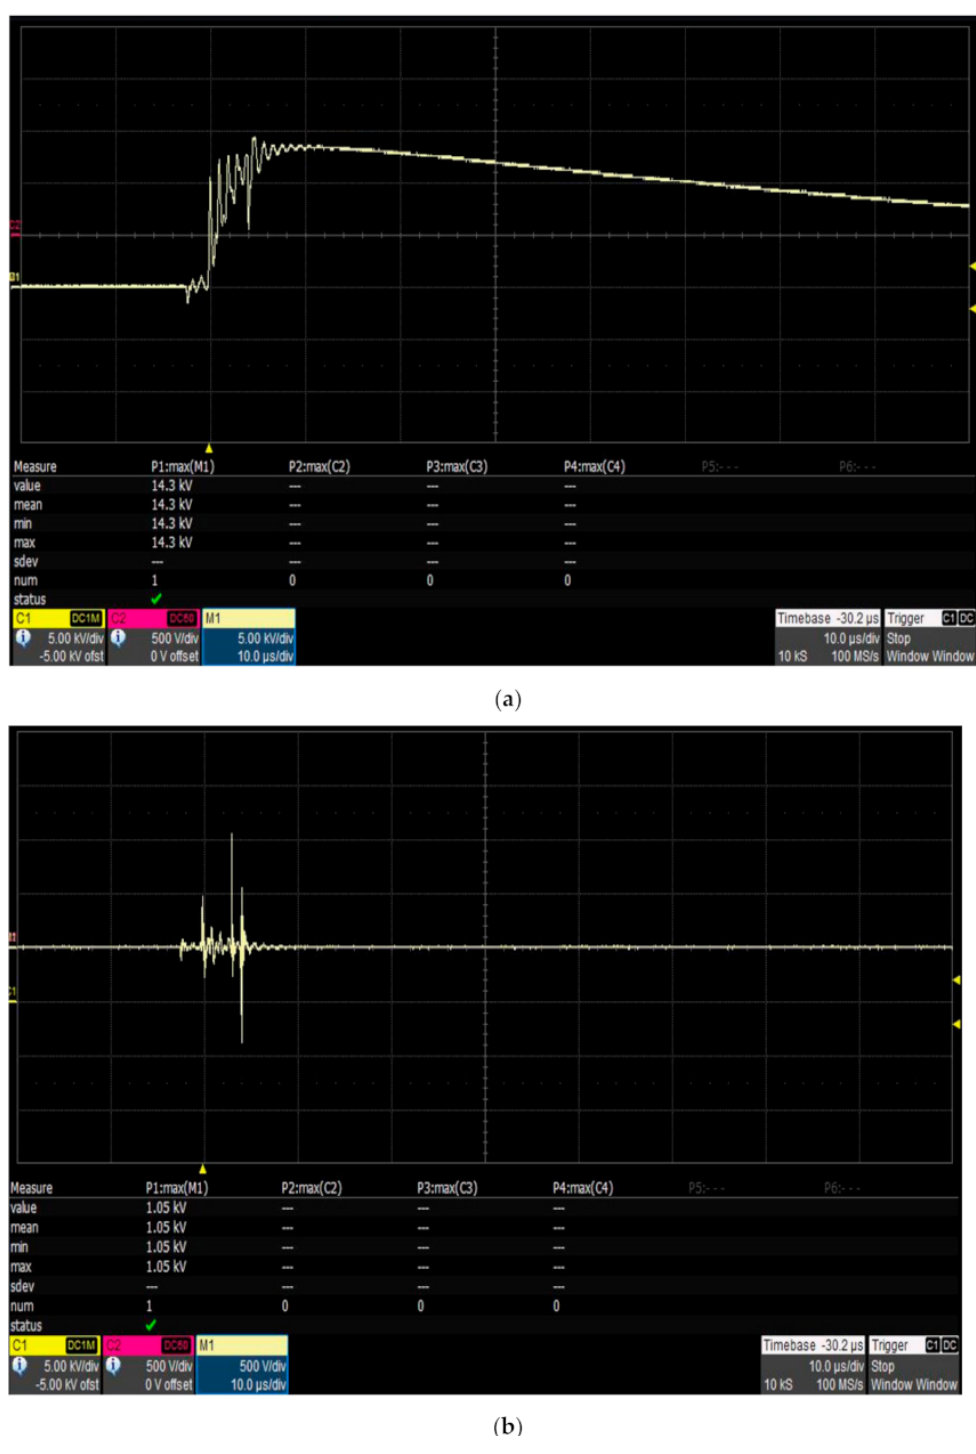
Figure 3. Measured traces on the modem for the case of no damage to the modem for configuration (h) installed at site 2b ( a ) Voltage trace measured with voltage probe 2 (x scale is 10 µ s/div, and y scale is 5 kV/div); ( b ) Current flows through the modem, measured with current transformer (CT) 2 (x scale is 10 µ s/div, and y scale is 5 kV/div, and the voltage magnitude is multiplied by 10, since the CT used had a sensitivity of 0.1